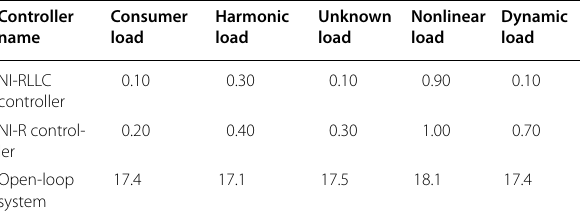
Table 8 RMS voltage error for different loads of SISO system Controller name